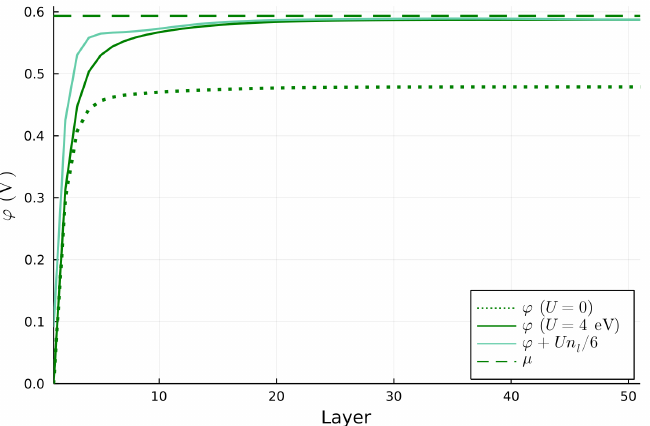
Figure 6. Behaviour of ϕ and ϕ + Un l /6 as a function of the layer position in the presence of Coulomb interactions for n 2 D = 1 × 10 14 cm − 2 ( upper panel ), n 2 D = 2 × 10 14 cm − 2 ( middle panel ) and n 2 D = 3 × 10 14 cm − 2 ( lower panel ). The dashed line represents the corresponding Fermi level, while the dotted line is the corresponding potential in the absence of Coulomb interactions.